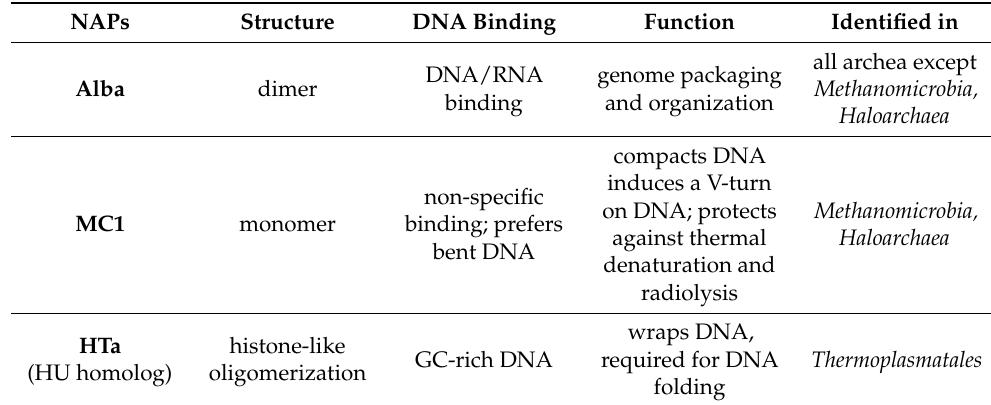
Table 2. Characteristics of archaeal